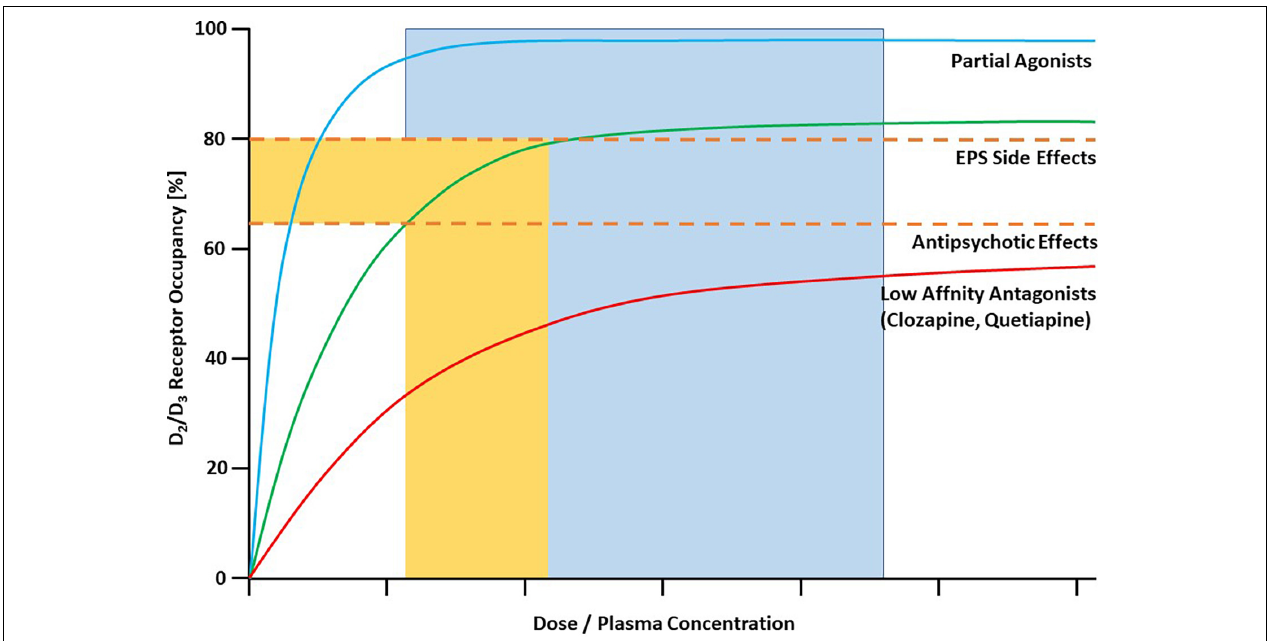
FIGURE 1 | Characteristic binding curves of antipsychotic drugs in human striatum as measured with PET. Dashed lines represent threshold occupancy values for EPS (80%) and antipsychotic effects (65%). Most antipsychotics, including most of the SGAs, are characterized by the green line. They reach optimal occupancy (65–80%) in a “therapeutic window” of corresponding plasma concentrations. Antipsychotics with low affinity for D 2 /D 3 receptors are described by the red line. Even at very high plasma concentrations they usually do not cross the 80% threshold for EPS. They exert antipsychotic effects despite relatively low occupancy in the striatum. All clinically available partial agonist antipsychotics are characterized by the blue binding curve. They have antipsychotic effects only at almost total saturation of D 2 /D 3 receptors (in the flat part of the curve), represented by the blue area. The upper threshold is not sharply defined. Copyright © 1969, Elsevier. From